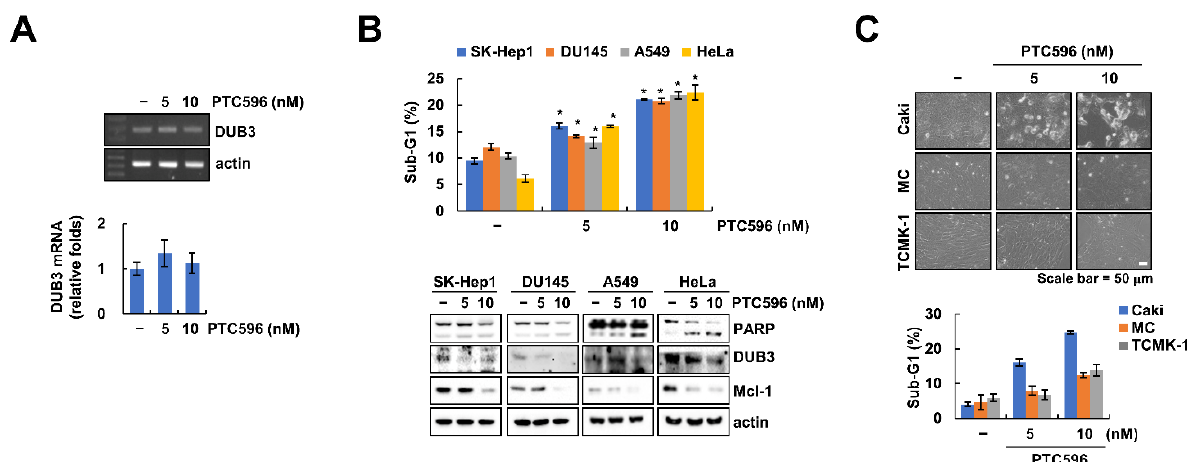
Figure 5. PTC596 induces apoptosis in various cancer cells. ( A ) Caki cells were treated with PTC596 (5, 10 nM) for 24 h. The mRNA levels were quantified by RT-PCR (upper panel) and real-time PCR (lower panel); ( B , C ) Cancer (SK-Hep1, DU145, A549, and HeLa) and normal cells (MC and TCMK-1) were treated with PTC596 (5, 10 nM) for 24 h. The sub-G1 population and protein expression were measured by flow cytometry and Western blotting ( B , C ). Cell morphology was measured by interference light microscope ( C ). * p < 0.01 compared to the control.